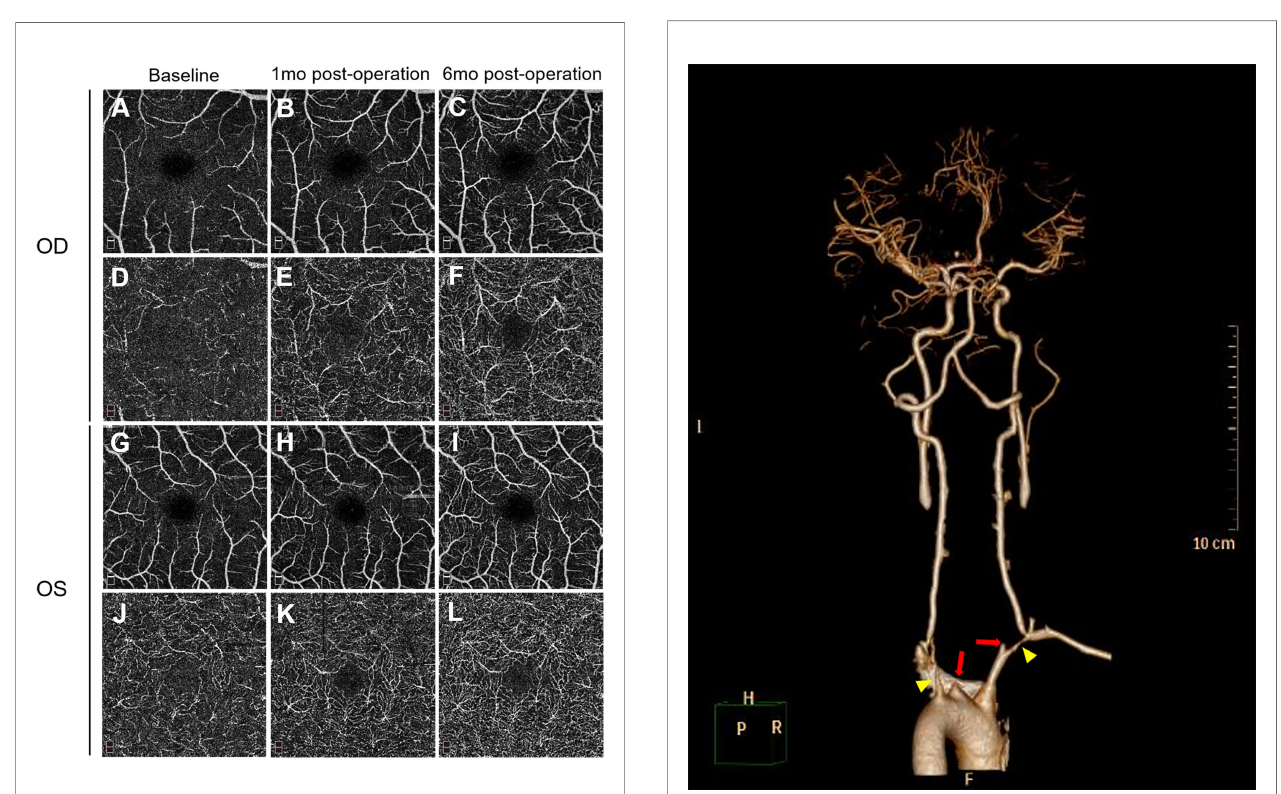
FIGURE 3 | Pre- and postoperative 3.0 * 3.0 mm optical coherence tomography angiography (OCTA) images. Super fi cial capillary plexus (SCP) in the right eye (A – C) and left eye (G – I) preoperatively and at two follow-up visits (1 and 6 months) illustrate a gradual increase of macular vessel density. Deep capillary plexus (DCP) in the right eye (D – F) and left eye (J – L) reveals similar vascular restoration, along with reconstruction of the perifoveal anastomotic capillary arcade. mo, month(s).